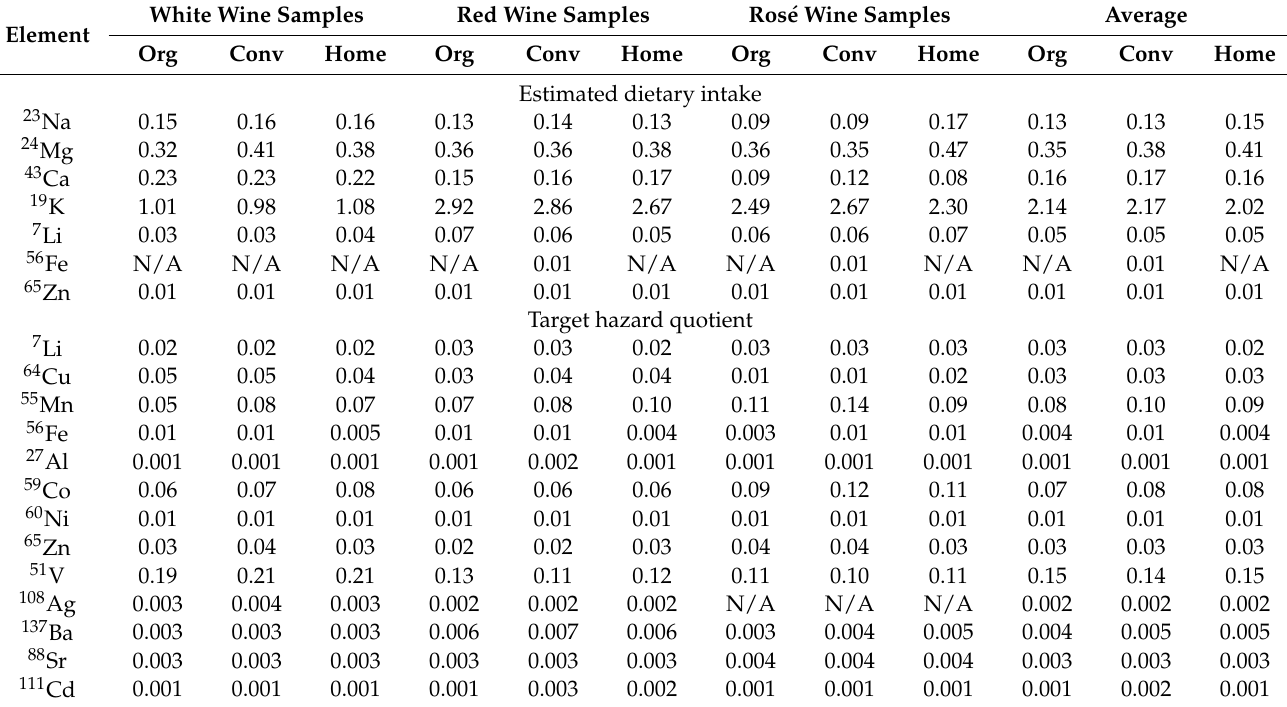
Table 4. Estimated dietary intake (mg/kg body weight per day) and target hazard quotients based on a 250 mL wine per day per ca